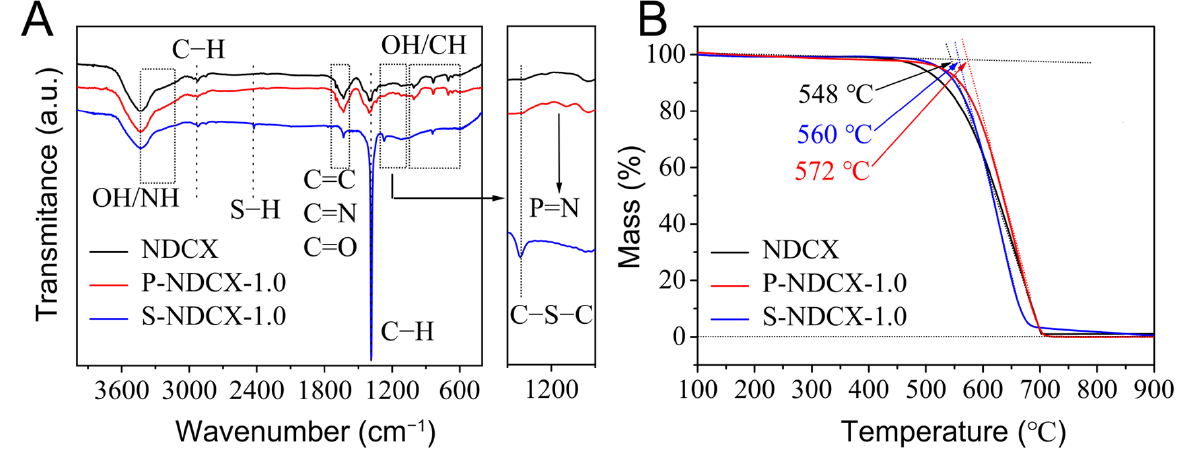
Figure 3. ( A ) FT ‐ IR spectra and ( B ) TGA profiles of the NDCX, P ‐ NDCX ‐ 1.0 and S ‐ NDCX ‐ 1.0. Figure 3. ( A ) FT-IR spectra and ( B ) TGA profiles of the NDCX, P-NDCX-1.0 and S-NDCX-1.0.